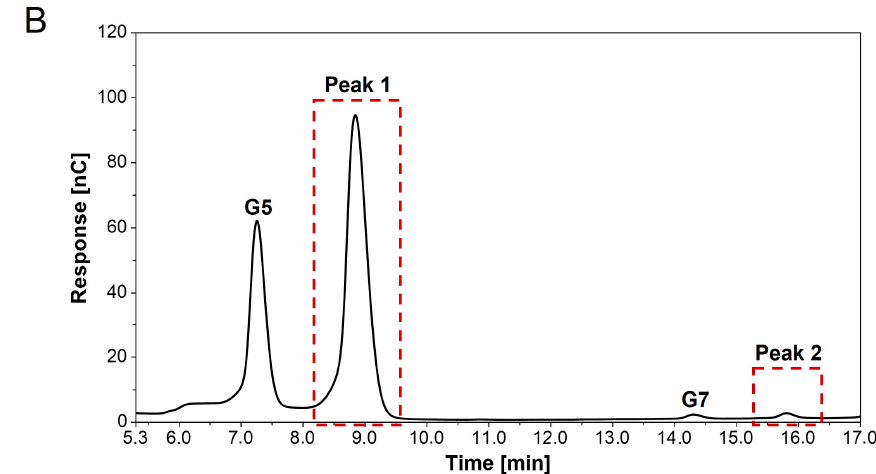
Figure 5. HPAEC-PAD chromatograms of in vitro AcbQ assay with acarbose and maltotriose. De- tection of α -1,4-glucans with di ff erent chain lengths (G1–G7). ( A ) A 400-fold dilution of enzyme reaction. ( B ) A 40-fold dilution of enzyme reaction. Red boxes mark the two new identi fi ed peaks.